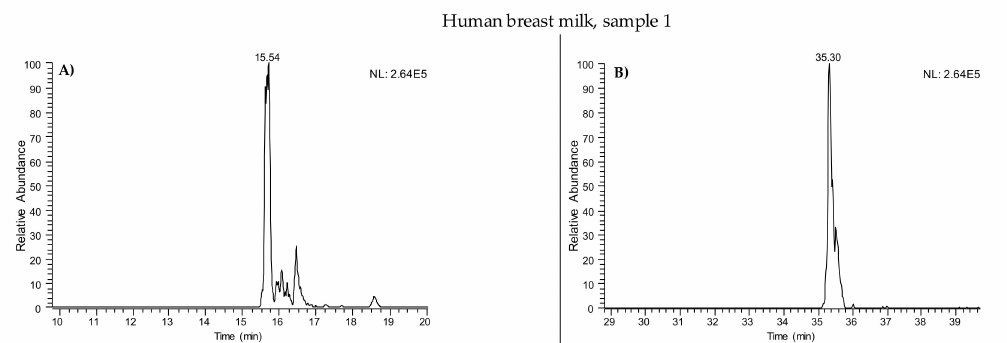
Figure 3. Chromatographic separation of quantifier ion m / z = 708.4, z = 2 (panel A ) and qualifier ion m / z = 764.4, z = 2 (panel B ) oh human leptin detected in human breast milk sample